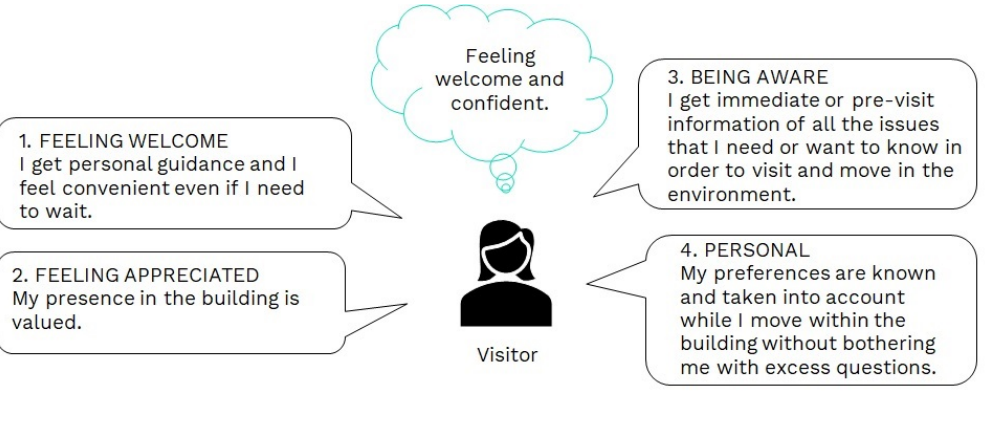
Figure 8. The UX vision and UX goals for visitors.